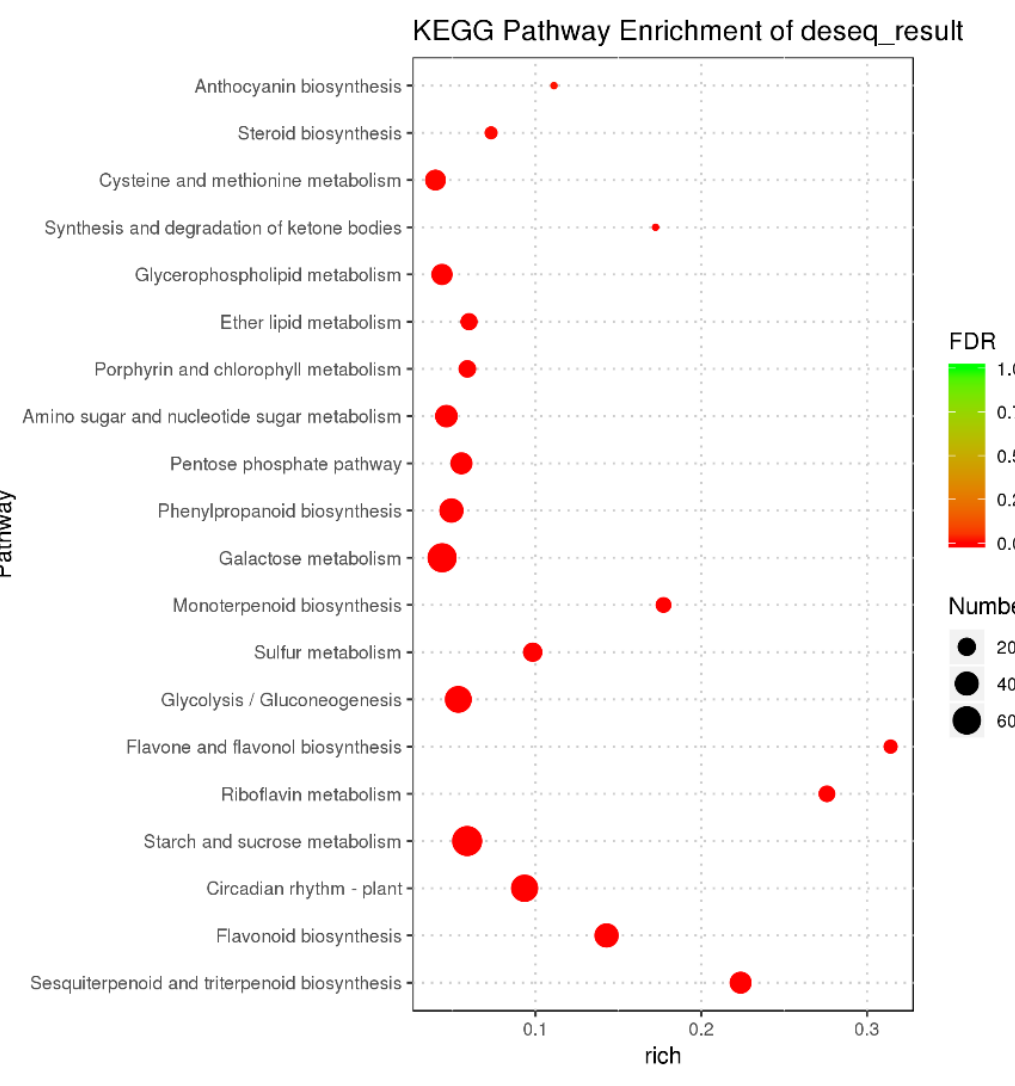
Figure 5. DEG analysis by the KEGG pathway of C. oleifera leaves under WL vs. RL.